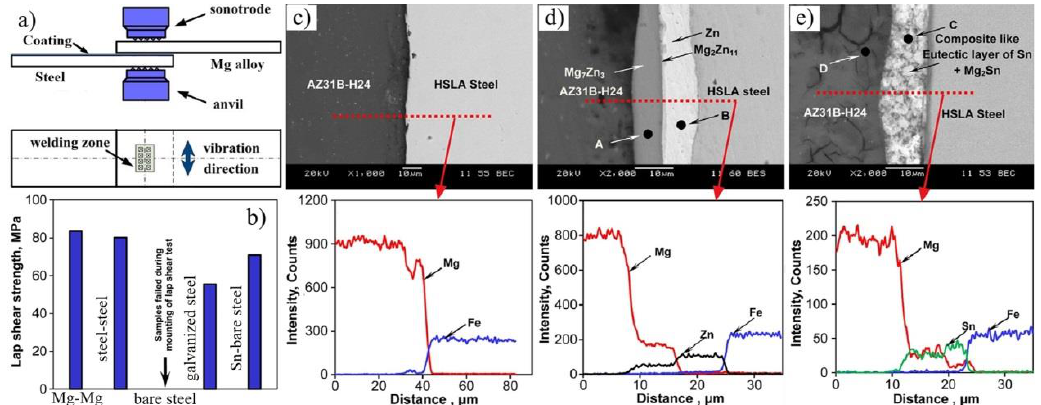
Figure 27. Mg/steel USW process [91] ( a ) schematic diagram of USW process; ( b ) Lap shear strength for different coated steel; ( c ) Mg–to–bare steel; ( d ) Mg–to–galvanized steel and ( e ) Mg–to–bare steel with Sn interlayer